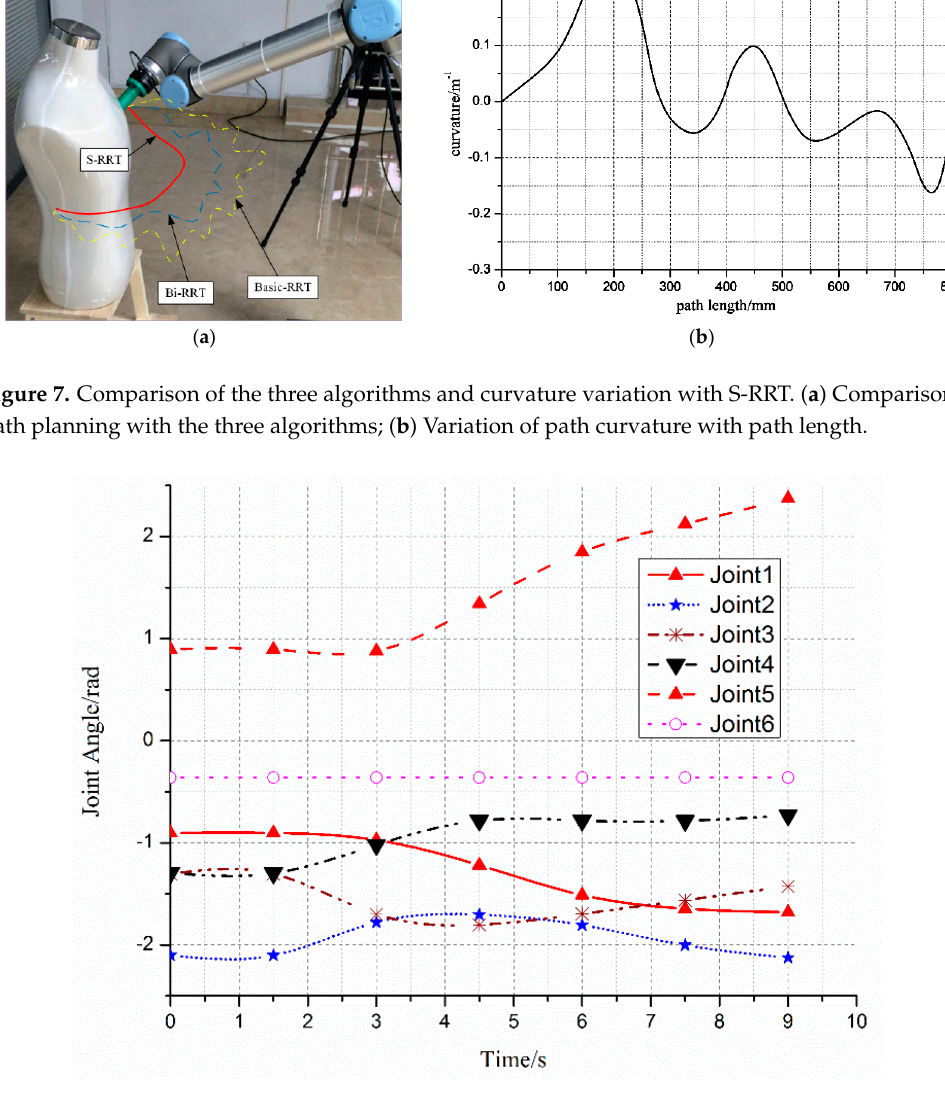
Figure 8. Variation of each joint angle during the process of obstacle avoidance.